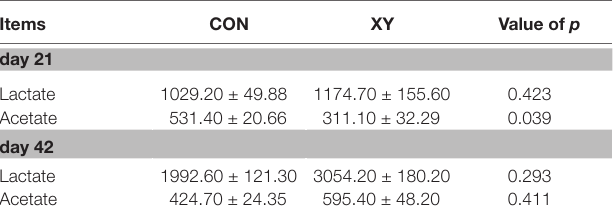
TABLE 5 | Effects of AT-xynA on lactate and acetate concentrations in ileal digesta of broilers (mg/kg). 1